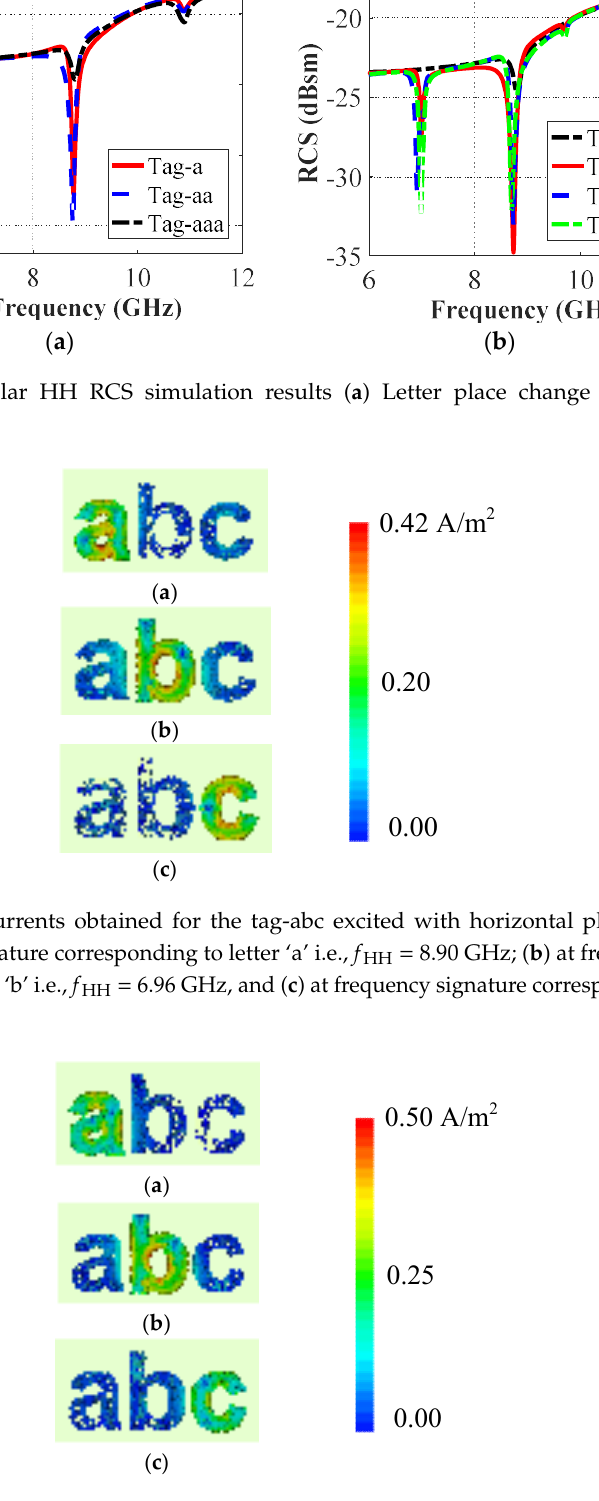
Figure 12. Surface currents obtained for the tag-abc excited with vertical plane wave: ( a ) at unique frequency signature corresponding to letter ‘a’ i.e., f VV = 10.97 GHz; ( b ) at frequency signature corresponding to letter 'b' i.e., f VV = 6.97 GHz, and ( c ) at frequency signature corresponding to letter ‘c’ i.e., f VV = 12.44 GHz.